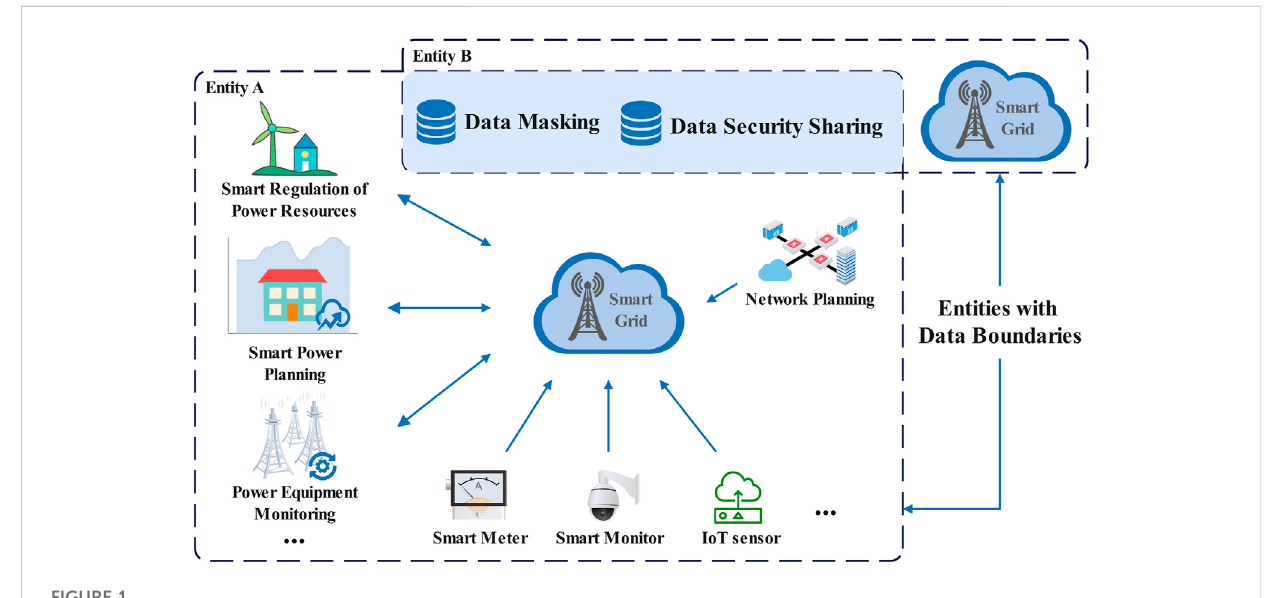
FIGURE 1 Entities with data